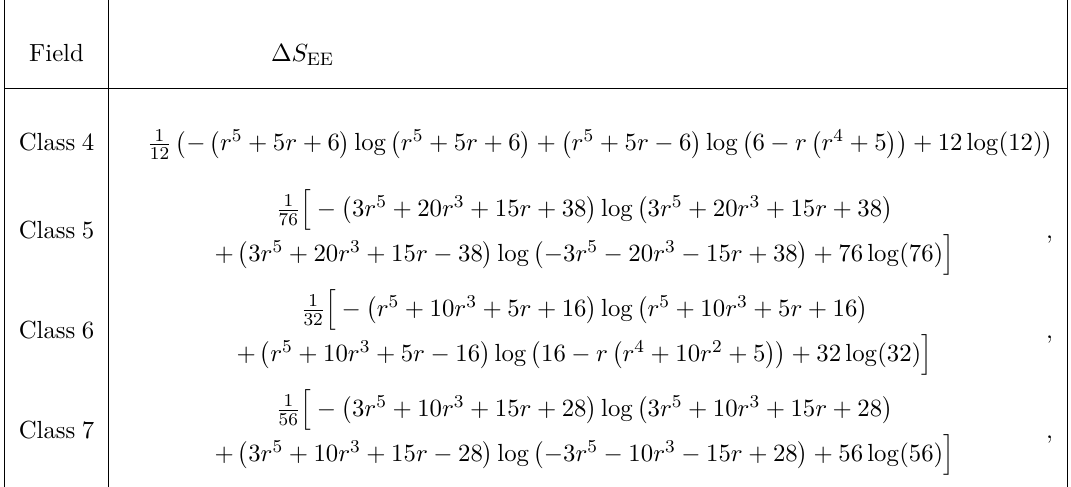
Table 6 . Entanglement entropy of components transforming as tensors under SO(2) T × SO(2) L .